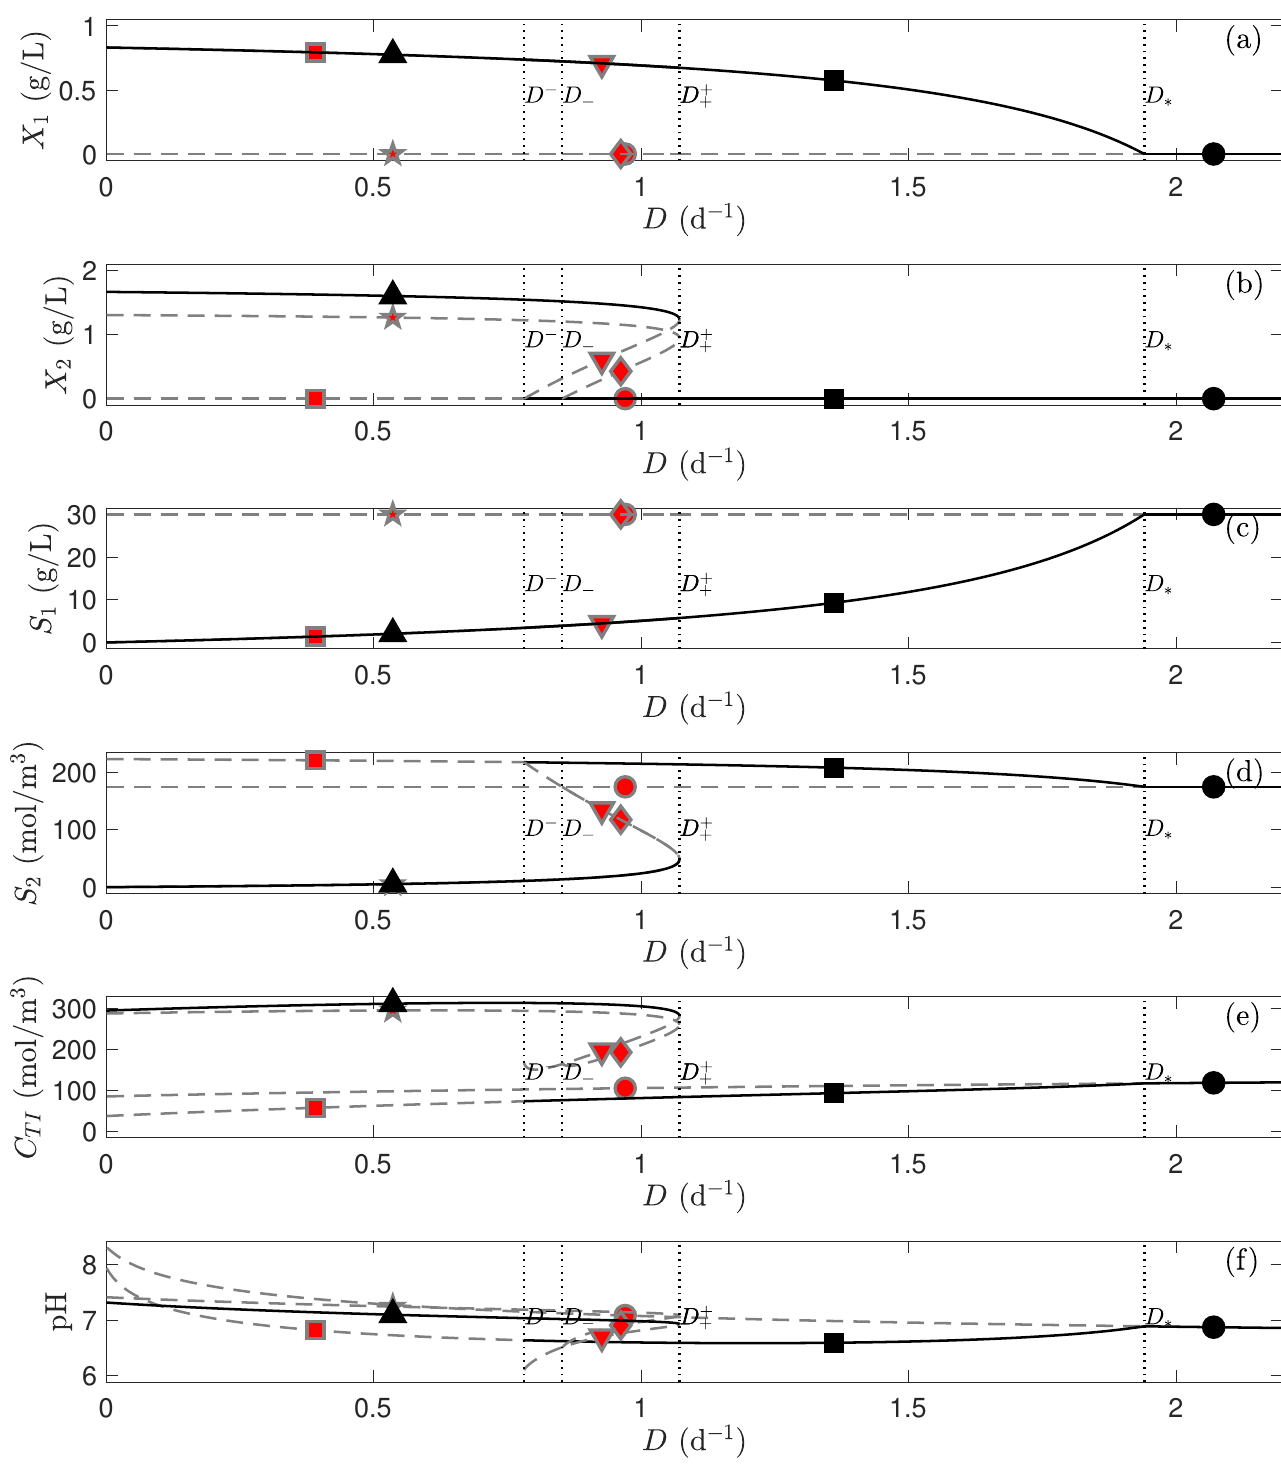
Figure 1. Bifurcation and stability analysis of the modified AM2 model with the parameters in Table 2. ( a ) acidogenic biomass, ( b ) methanogenic biomass, ( c ) COD, ( d ) VFA, ( e ) CTA, and ( f ) pH with bifurcations at D − = 0.78d − 1 D − = 0.85d − 1 , D + = D + = 1.08d − 1 and D ∗ = 1.94d − 1 . The continuous lines with black markers represent stable EP, the dashed lines with red markers represent unstable EP, and the dotted lines are the bifurcation points, while the shape of markers indicates the regions for each EP: = EP1, (cid:4) = EP2, (cid:70) = EP3a, (cid:7) = EP3b, (cid:72) = EP4a, and (cid:78) = (cid:32)